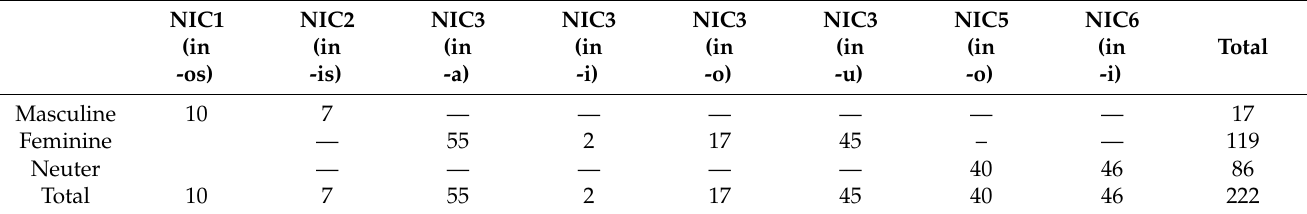
Table 1. Inflection classes of Kaliard á Italian, French and English loan